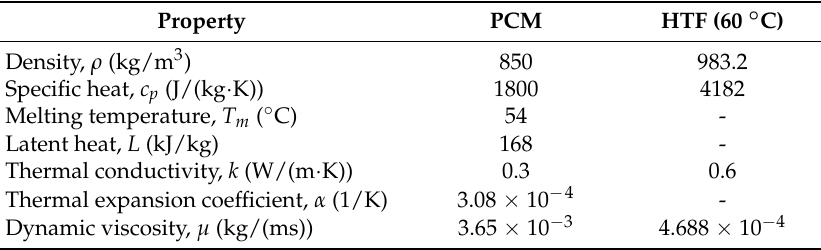
Table 1. Thermophysical properties of PCM and